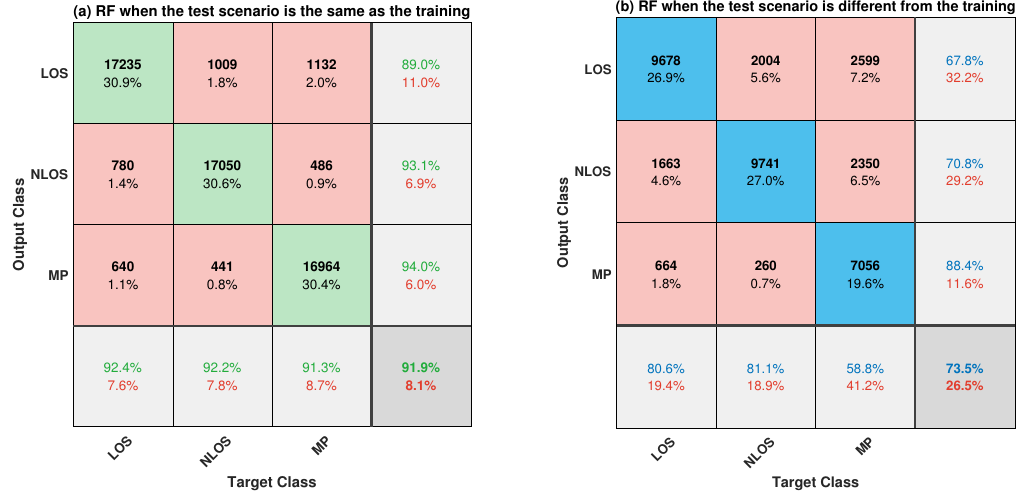
Figure 9. Comparison of the multi-class classification results for the RF classifier using the confusion matrices in two scenarios: ( a ) the test dataset obtained from the same conditions as the training data; ( b ) the test dataset collected in a different condition from the training. In the evaluation, fifty decision trees were used in the forest of the applied RF